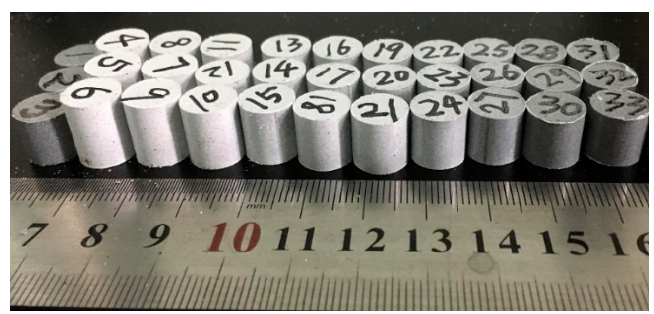
Figure 1. Reactive material samples with different molding pressures.